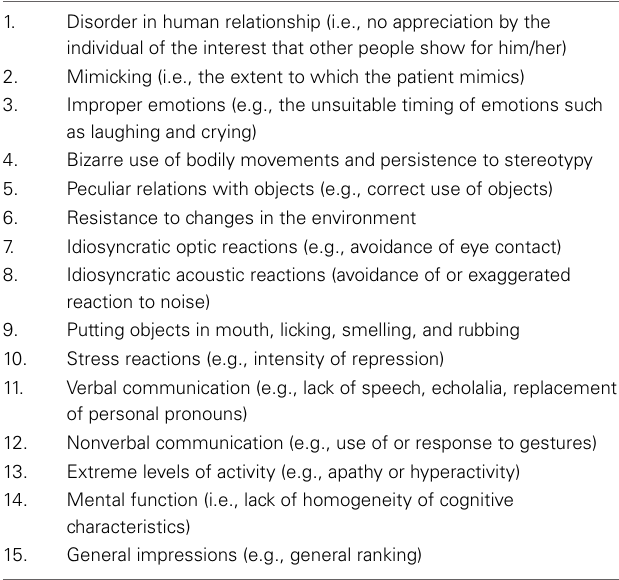
Legend to table: ranking of symptoms: 1, normal for age; 2, mild disorder; 3, moderate disorder; 4, serious disorder. For each of these 15 items a cumulative score is derived by summing 1–4 points for each